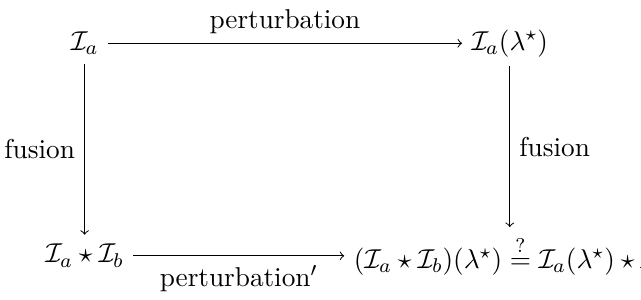
Figure 2 . When is there a perturbation on the fusion product such that the diagram